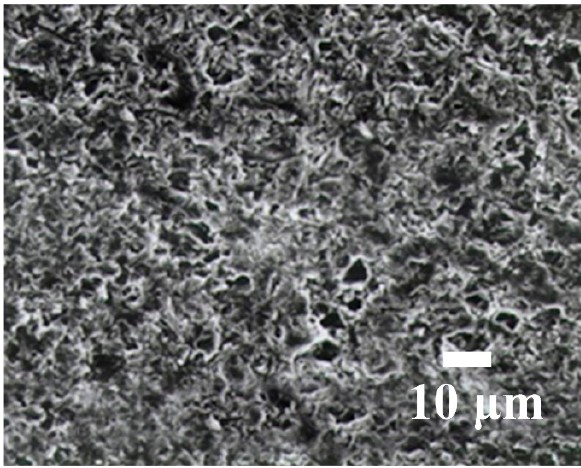
Figure 10. Fracture cross section for Al 2 O 3.